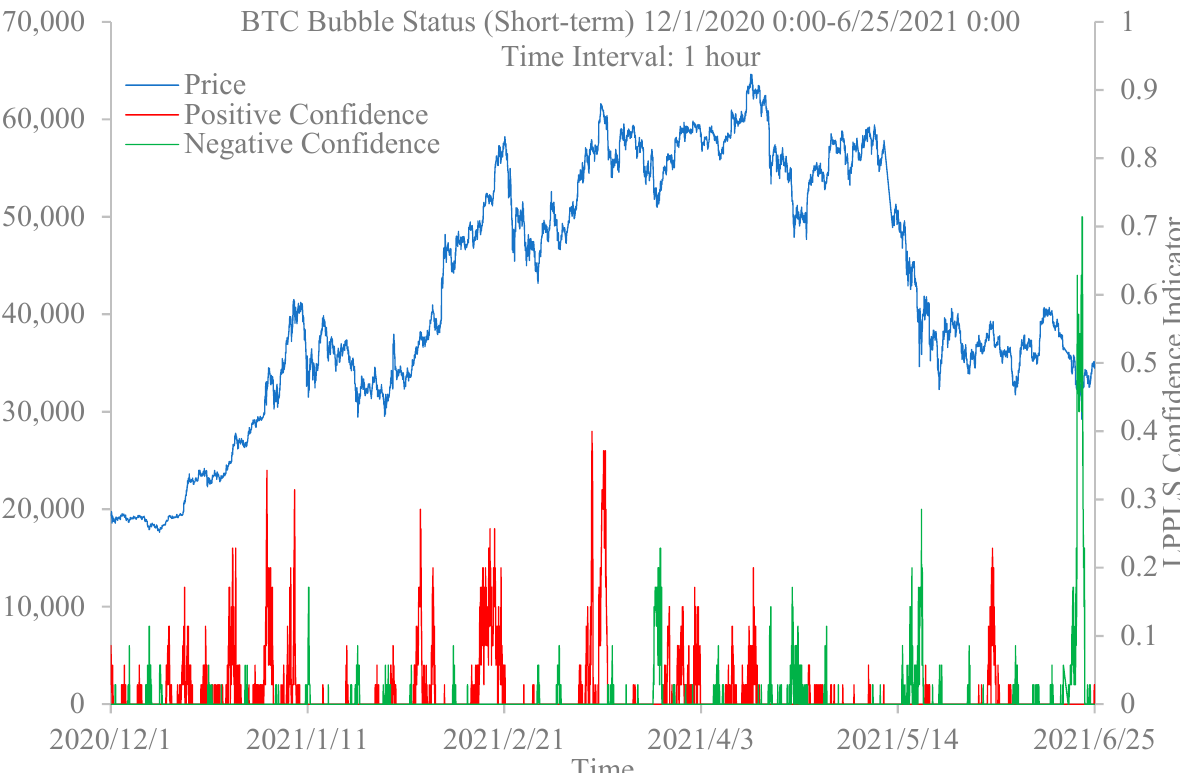
Figure 9. Short-term hourly LPPLS confidence indicator for positive bubbles is shown in red and negative bubbles in green (right scale), along with the Bitcoin price in blue (left scale) from 12/1/2020–6/25/2021.